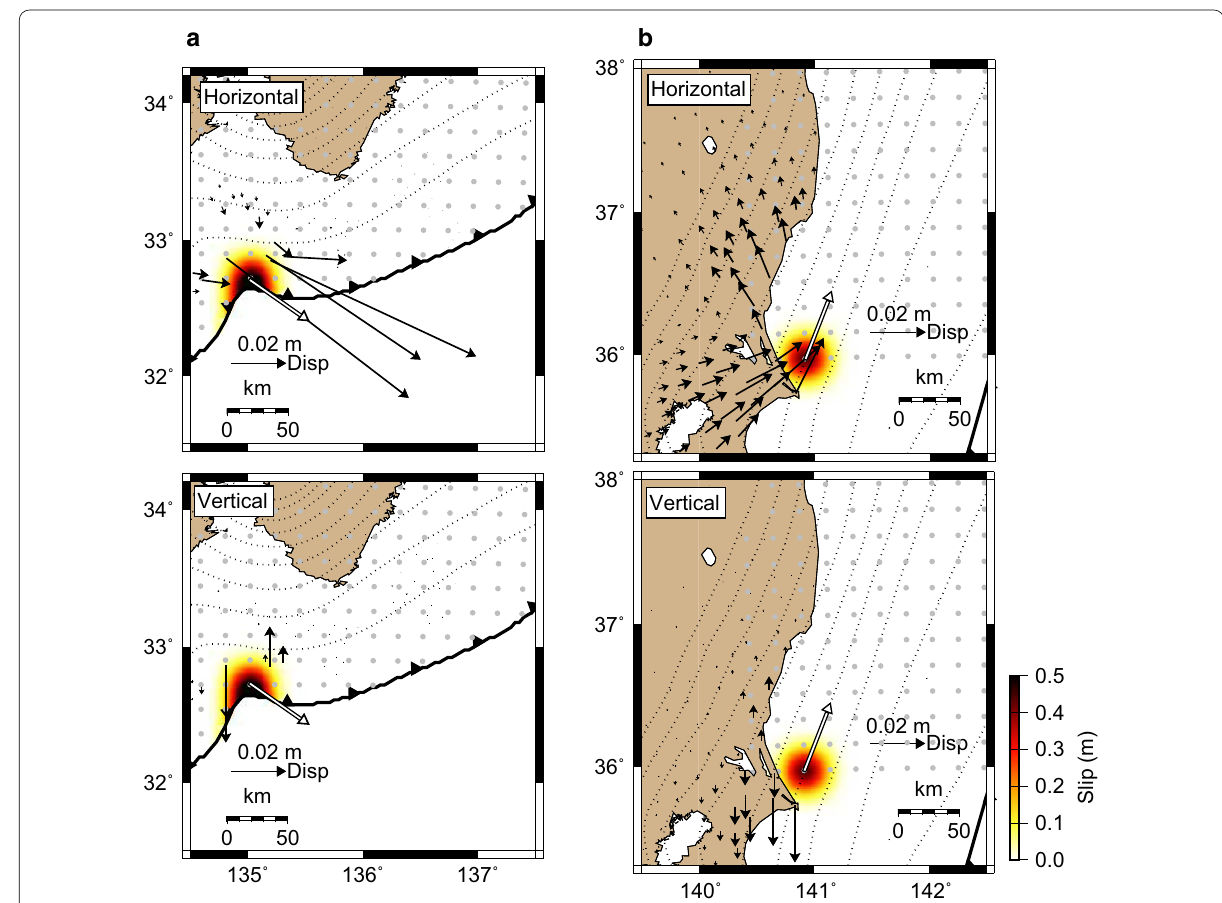
Fig. 5 Examples of GF calculated based on FE modeling. a A unit slip and its response displacement in the direction opposite to the plate convergence in Nankai Trough and b one in the direction perpendicular to the plate convergence in the Japan Trench subduction zone. Note that unit slip in the location beyond the trench or trough axis is set forcibly zero in a . Gray dots denote the central point of B-spline function shaped slip applied in a subfault. The color map shows slip distribution. The black arrows denote the horizontal (top) and vertical (bottom) surface displacements due to the fault slip. The white arrows denote fault slip